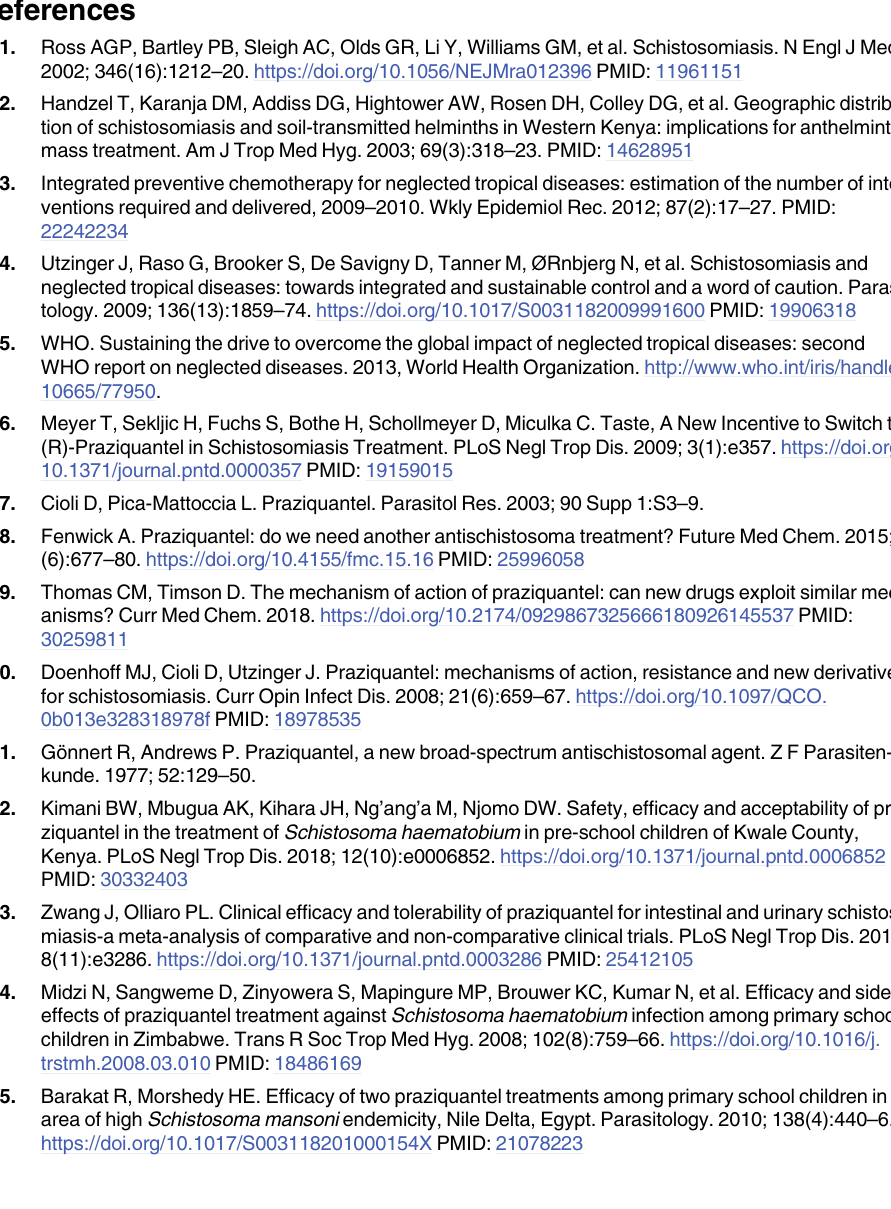
S11 Table. The comparison of racemic PZQ alone, and with drug "B" in reducing hepatic granuloma diameter in murine models. PZQ, praziquantel. S12 Table. Comparison of the results of this systematic review in comparison to tuberculo- sis.